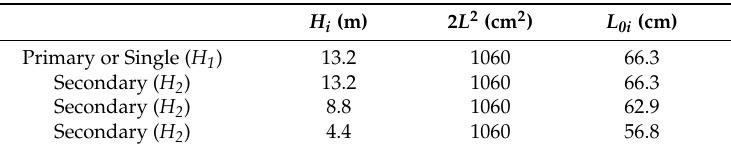
Table 1. Physical dimensions of obstacles used in HyIV-CNRS-SecORo.